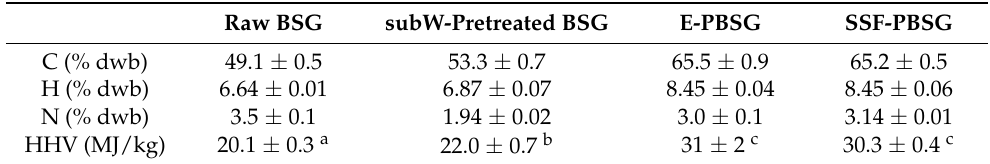
Table 5. (CHN) and estimated heating value (HHV) of raw BSG, subW-pretreated BSG, solid residue remaining after enzymatic hydrolysis of pretreated BSG at 8% ( w/v ) solids loading (E-PBSG) and solid residue remaining after SSF attempt of pretreated BSG at 25% solids loading (SSF-PBSG). Values are expressed as mean ± standard deviation from triplicate determination. Raw